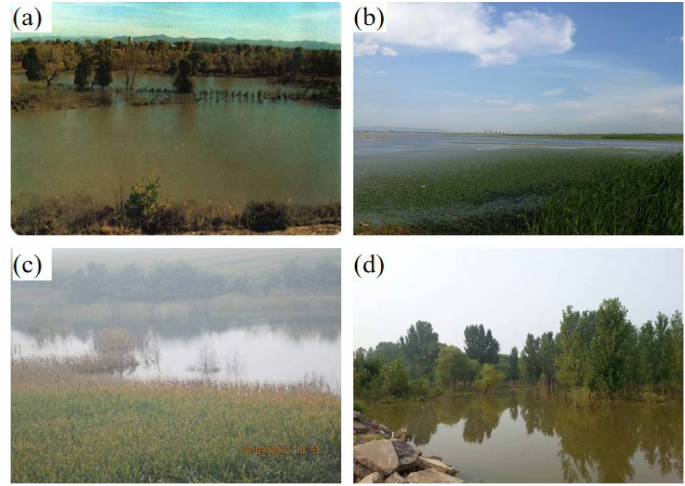
Figure 9. Coal mining under water. ( a ) Wuyang Coal ( b ) Wangzhuang Coal ( c ) Gaohe Coal ( d ) Guozhuang